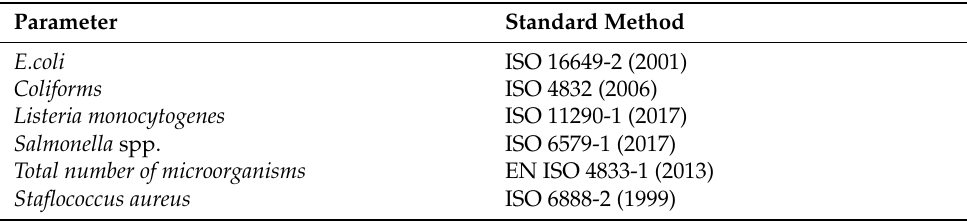
Table 3. The standard methods used for microbiological